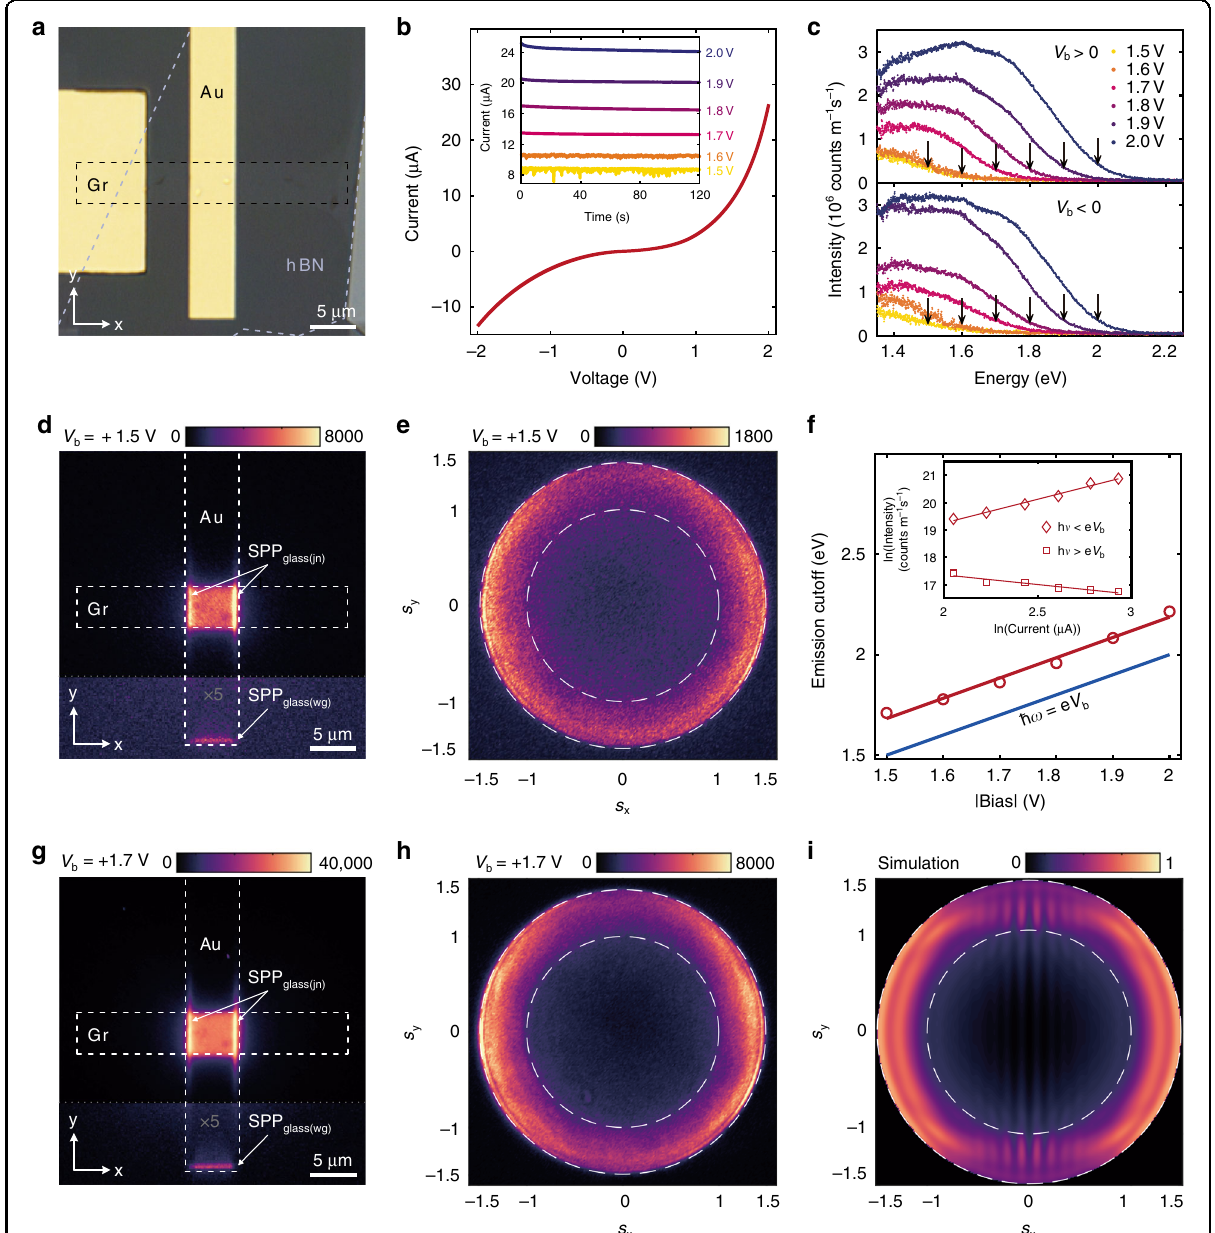
Fig. 4 Electrical and optical characteristics of the Au//hBN//Gr TJ. a Optical image of the fabricated Au//hBN//Gr TJ. Dashed lines represent the outline of Gr (black) and hBN (gray) layers. b Measured current-voltage ( I-V ) characteristics of the device. Inset shows the I ( t ) traces representing current values recorded over 120 s for a constant bias in the range of 1.5 to 2.0 V. c Light emission spectra for positive (top) and negative (bottom) bias ( V b ) in the range of 1.5 to 2.0 V, collected over 120 s. Downward arrows indicate the theoretical energy quantum cutoff ℏ ω = |e V b |. Spectral intensity is corrected for the detection ef fi ciency of the optical system (see Supplementary Fig. S4). f Maximum emission energy (emission cutoff) of the experimental spectra shown in ( c ), averaged over + V b and – V b (open circle) and the linear fi t (red solid line). The Blue solid line represents ℏ ω = | e V b |. Inset shows the emission intensity integrated below (open rhomb) and above (open square) the theoretical quantum cutoff and the solid lines are power-law fi t I β to the data (see the text). Real plane (( d ) and ( g )) and BFP (( e ) and ( h )) images of the light emission from the TJ at two representative bias voltages (1.5 V and 1.7 V), for which a spatially localized intensity enhancement is distinguishable at the right and left edges of the TJ ( x -direction). For the BFP images, the inner dotted-circle refers to s = 1 and the outer dotted-circle corresponds to NA of the objective, s = 1.49. i BFP image for the radiation outcoupling from a 5 × 5 μ m 2 Au//hBN//Gr TJ simulated using fi nite difference time domain method. Intensity scales in real and BFP images are adjusted to give the best possible contrast for the emission